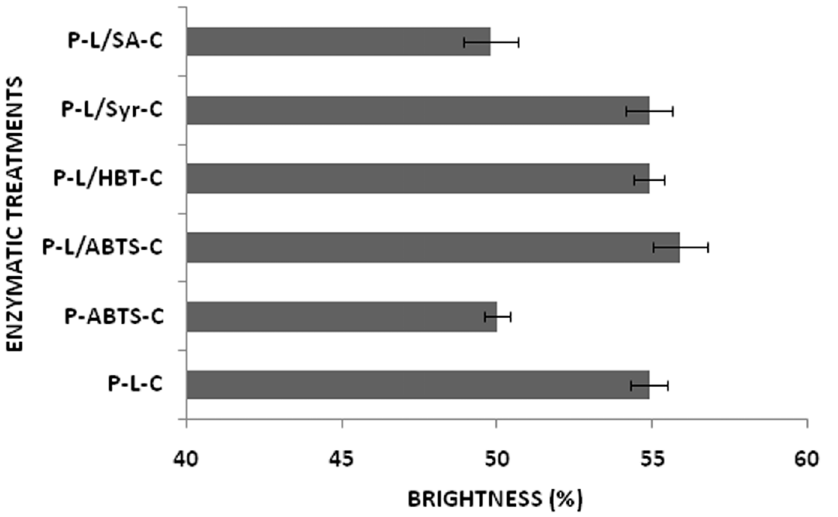
Figure 1. Effect of mediators (ABTS - 2,2 9 -azino-bis-3-ethylbenzothiazoline-6-sulphonic acid, HBT - 1-hydroxybenzotriazole, Syr - syringaldehyde) and inhibitor (SA – sodium azide) on the deinking of ONP pulp with laccase enzyme.